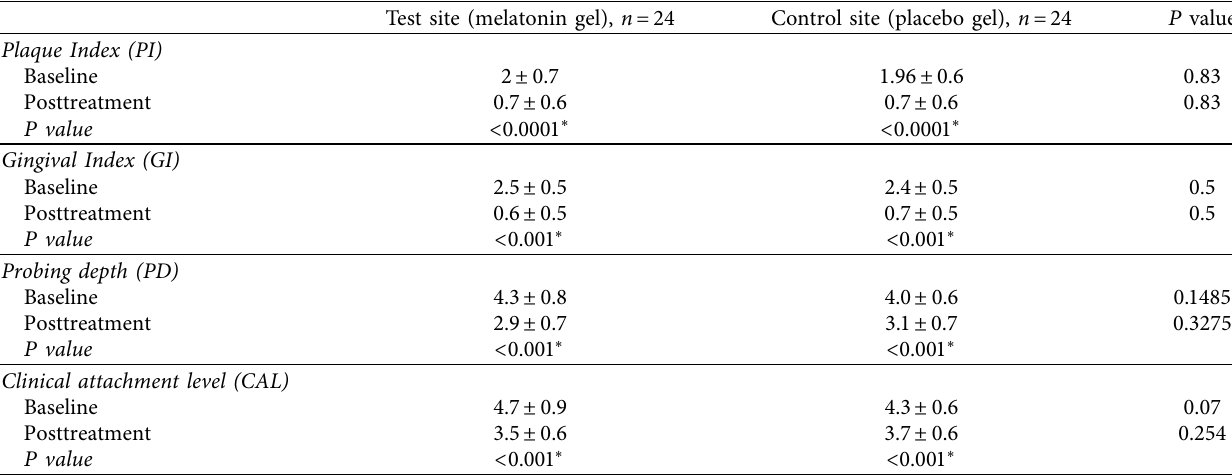
Table 1: Mean and standard deviation values for inter- and intragroup comparisons in all clinical variables between test and control sites.